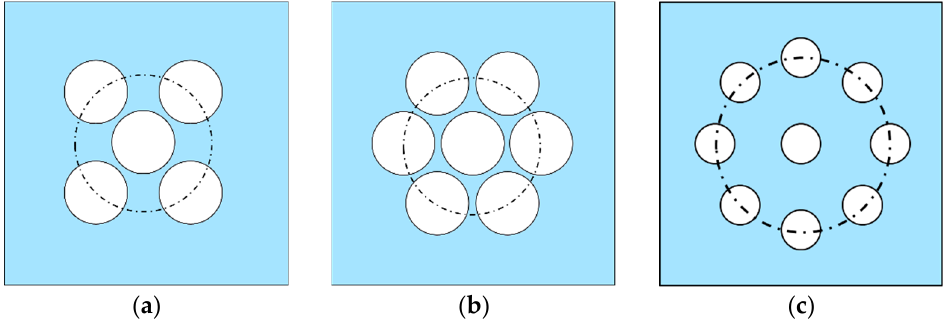
Figure 4. Examples of the arrays which meet Condition 2. ( a ) 5-element. ( b ) 7-element. ( c ) 9-element.